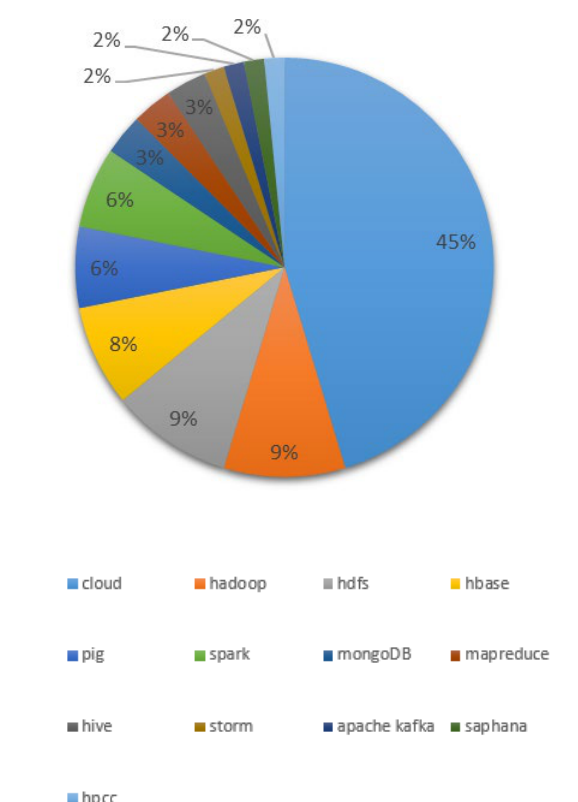
Figure 9. Percentage of publications per Big Data Technology used in real time remote sensing